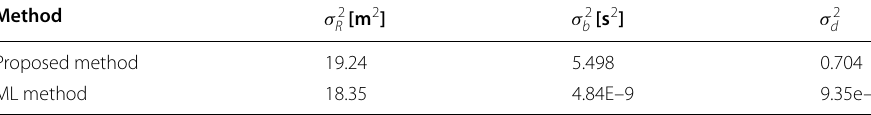
Table 5 GPS data variance estimates using the proposed method Method